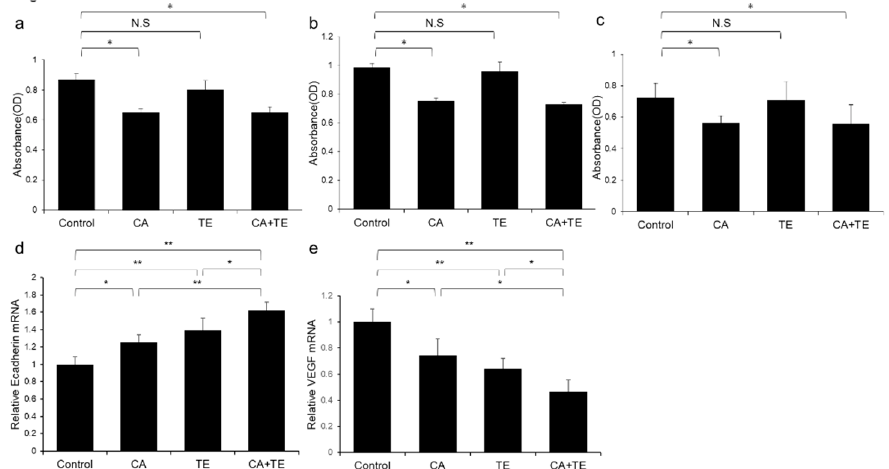
Figure 8. E ff ects of canagliflozin (CA; 10 µ M) and teneligliptin (TE; 5 µ M) on cell proliferation of ( a ) Figure 8. Effects of canagliflozin (CA; 10 µM) and teneligliptin (TE; 5 µM) on cell proliferation of HepG2 cells and ( b ) Huh7 cells. E ff ects of both agents on ( c ) cell proliferation and ( d ) E-cadherin and ( A ) HepG2 cells and ( B ) Huh7 cells. Effects of both agents on ( C ) cell proliferation and ( D ) E- ( e ) VEGF mRNA expression in human umbilical vein endothelial cells. Values represent mean ± SD cadherin and ( E ) VEGF mRNA expression in human umbilical vein endothelial cells. Values ( n = 8). * p < 0.05, ** p < 0.01. N.S.: No significance. represent mean ± SD ( n = 8). * p < 0.05, ** p < 0.01.